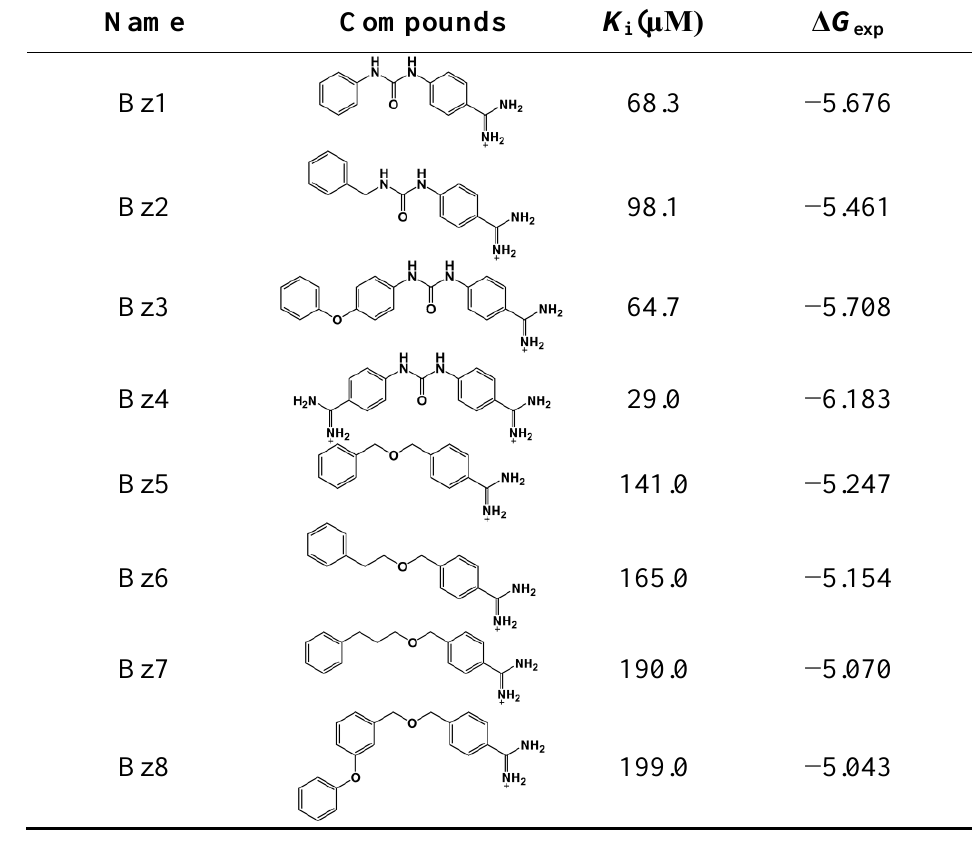
Table 1. Observed binding free energies for benzamidine derivatives. The experimental values of HRgpA:inhibitors binding free energy. K Δ G is the calculated value of binding free energy according to the exp